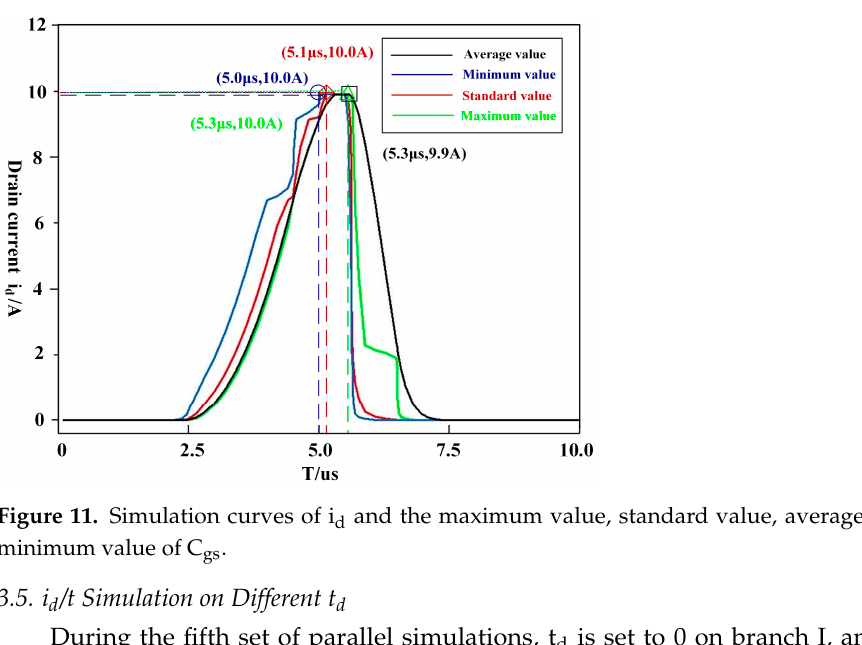
10 of 19 Figure 10. Simulation curves of id and the maximum value, standard value, average value, and minimum value of L s . 3.4. i d /t Simulation on Different C gs During the fourth set of parallel simulations, branch I and branch II are set to the standard values and the maximum, minimum, and average values, respectively. The sim- ulation curves of i d and the maximum value, standard value, average value, and minimum value of C gs are shown in Figure 11. i d is very sensitive to C gs during the switching process. On the branch with a smaller C gs , the turn-on time is short, the fluctuation range of i d is small, and the current overshoot is slight. After being turned on, C gs has little effect on r Δ i under static conditions. During the turn off of the SiC module, the branch with a smaller C gs has a faster opening speed and a smaller i d . The earlier the branch with a smaller C gs is opened, the V g first reaches